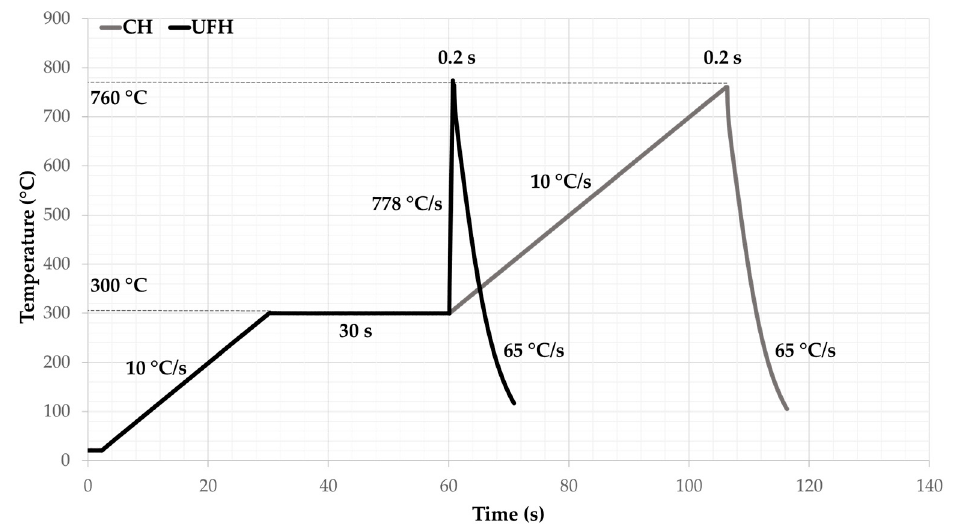
Figure 1. The parameters of both applied heat treatments. The conventional heat treatment (CH) consisted of a heating with rate of 10 °C/s to the peak temperature followed by quenching, while the heating rate of the ultra-fast heat treatment (UFH) was 780 °C/s. For both treatments, the isothermal soaking time was 0.2 s.